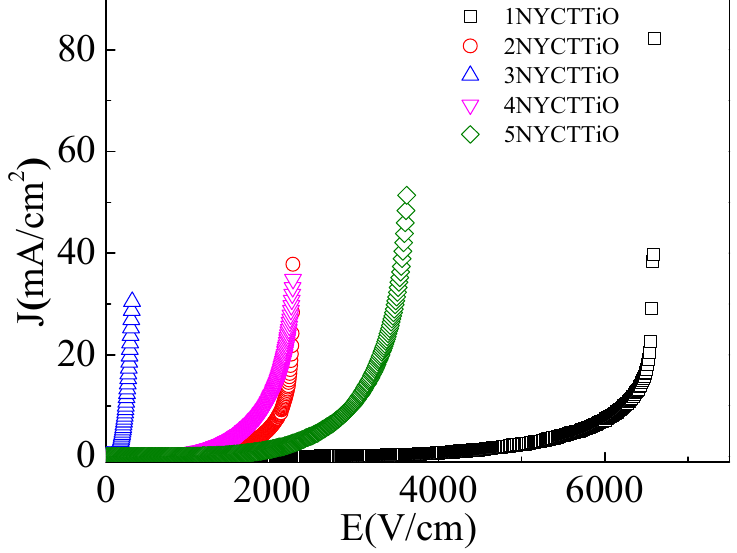
Figure 9. Nonlinear J-E characteristics of Na 1/2 Y 1/2 Cu 3 Ti 4.1 O 12 ceramics sintered at 1070 °C for 1, 5, and 15 h and sintered at 1080 and 1090 °C for 5 h.